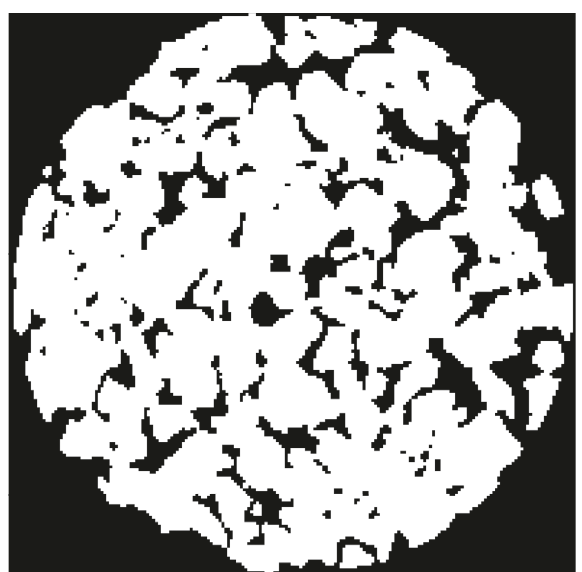
Figure 1: Binarization diagram of a bituminous mixture sample.